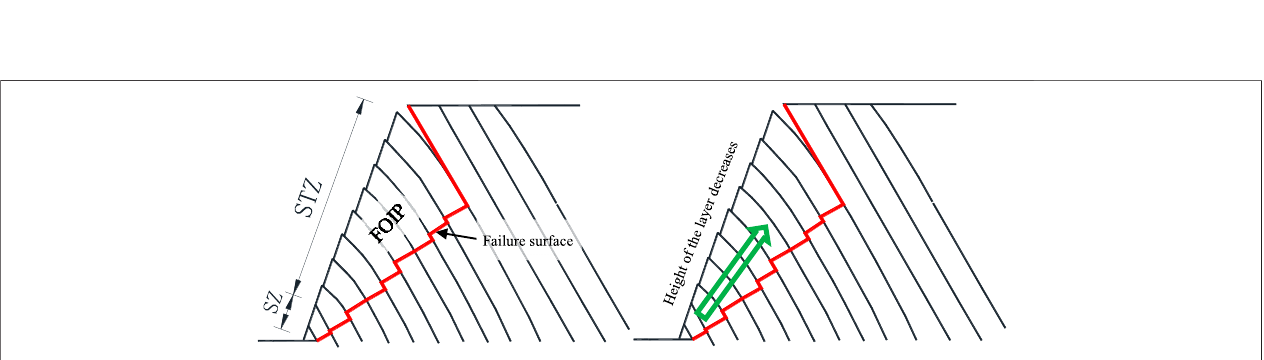
FIGURE 13 | The failure zones of an anti-dip bedding rock slope. SZ: sliding zone; STZ: superimposed toppling zone; FOIP: fi rst-order instability part.